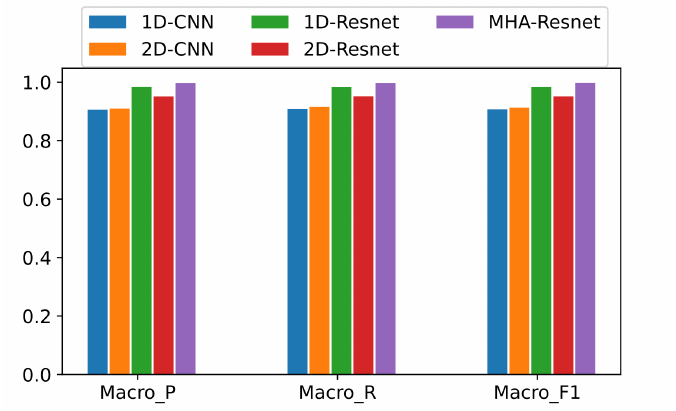
Figure 12. MHA-Resnet vs. Baseline Models on Macro-averaging Metrics.